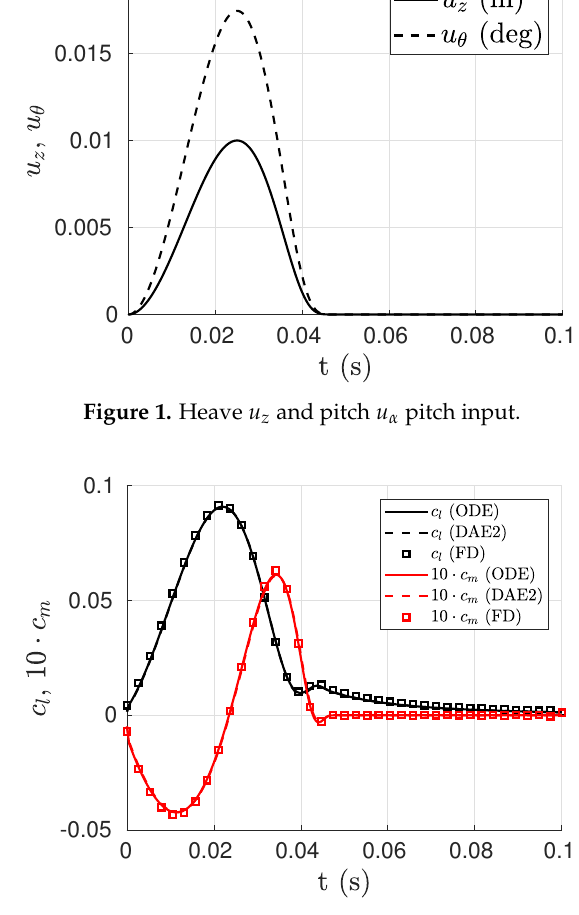
Figure 2. Lift and pitch moment coefficients ( c l , c m ) as predicted by the system of ordinary differential equations (ODE) and the system of differential algebraic equations (DAE) of index 2. Reference results obtained in the frequency domain (FD) are also